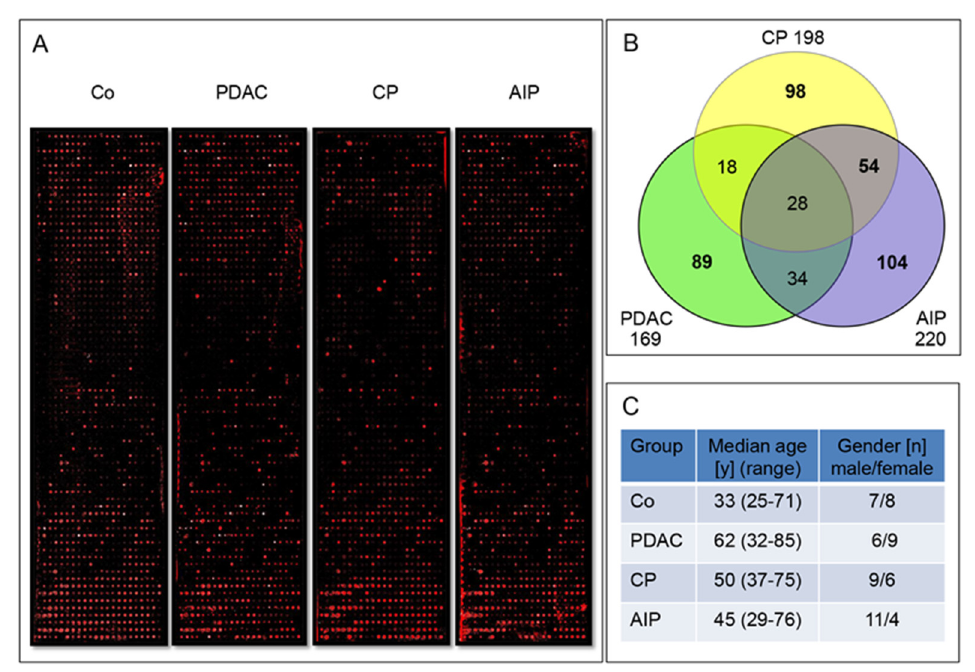
Figure 1. ( A ) Example of four microarrays equally spotted with 1600 human recombinant proteins each after incubation with enriched IgG serum fractions from healthy Co, PDAC, CP and AIP. Red dots indicate specific autoantigen / autoantibody complex formation and colour intensity represents the amount of the specific autoantibody bound. White dots indicate saturated signals with maximal intensity. For technical reasons, background signals were higher at the top and bottom end of the arrays. Still, the selection criteria permitted identification of real positive signals. ( B ) Number of autoantigens retrieved from the first sample set. The profiling allowed discrimination between disease-specific and disease-overlapping autoantibodies for PDAC, CP, and AIP. ( C ) Sample set 1 patients’ data was composed of 60 serum samples assembled in four groups.